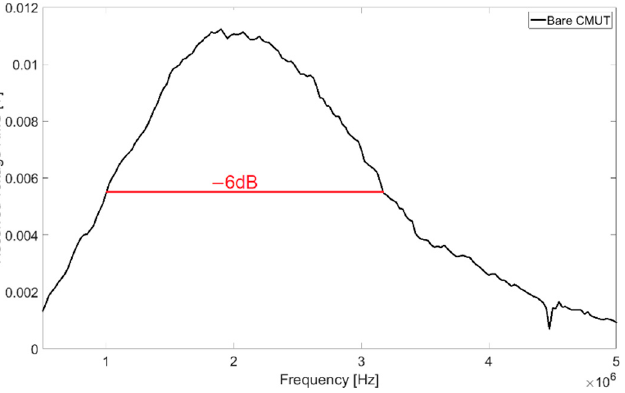
Figure 3. Frequency spectrum of an uncoated CMUT chip in Fluorinert FC-72, 60 V DC , 15 V AC , burst count 20.